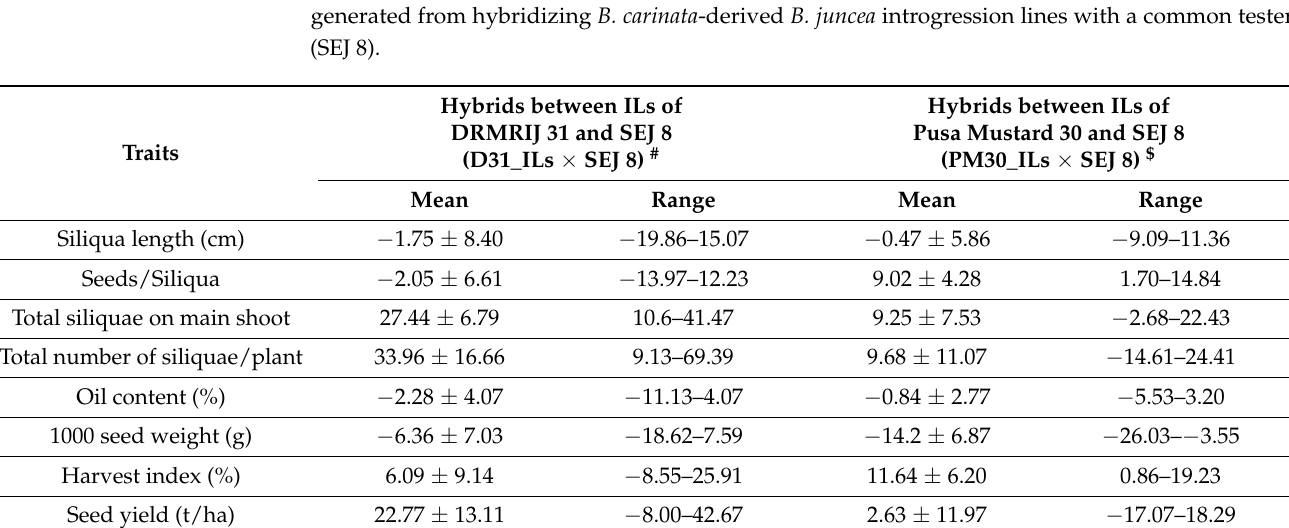
Table 3. Extent of standard heterosis (%) for seed yield and its contributing traits in test hybrids generated from hybridizing B. carinata -derived B. juncea introgression lines with a common tester (SEJ